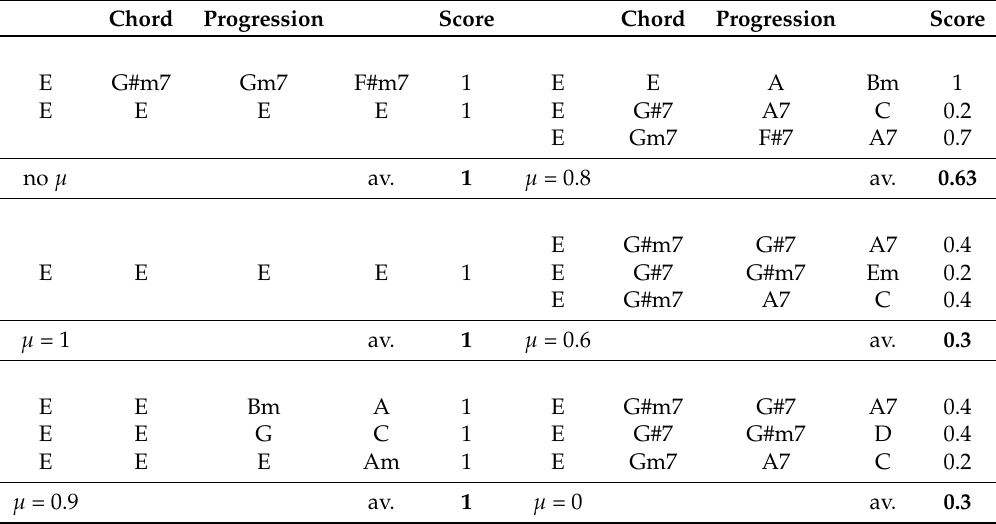
Table 1. New chord progressions given A-parts of Please Please